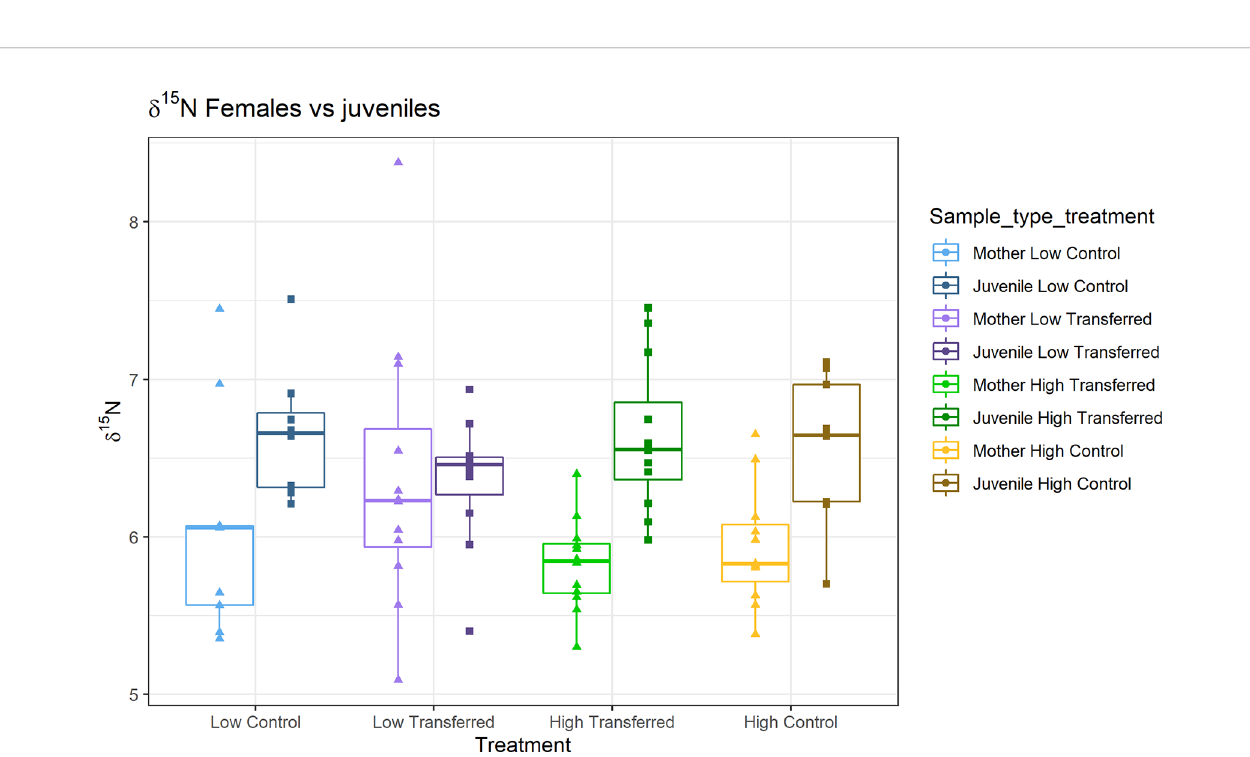
FIGURE 7 | Female and juvenile d 15 N at the end of the experiment. See Figure 2 for experimental details. The females are the lighter version of the treatment colors (left) and the corresponding juveniles are darker version of the treatment colors